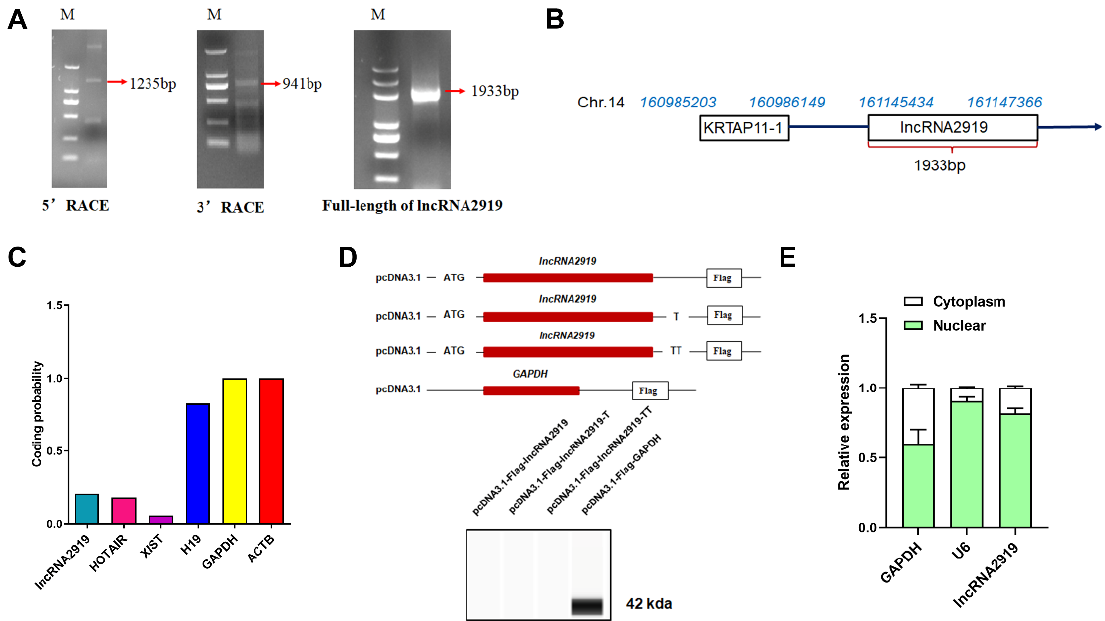
Figure 1. Cloning and analysis of the lncRNA2919 full-length sequence. ( A ) The lncRNA2919 full-length sequence was obtained through RACE. M indicated the DL 2000 DNA marker. ( B ) The information of lncRNA2919 located in the rabbit genome. The arrow indicates the direction of transcription (5 ′ to 3 ′ ). ( C ) The coding probability prediction of lncRNA2919 through CPC2. ( D ) The coding ability of lncRNA2919 was verified through the detection of the pcDNA3.1-Flag vector. ( E ) lncRNA2919 expression in the nucleus and cytoplasm of DPCs.